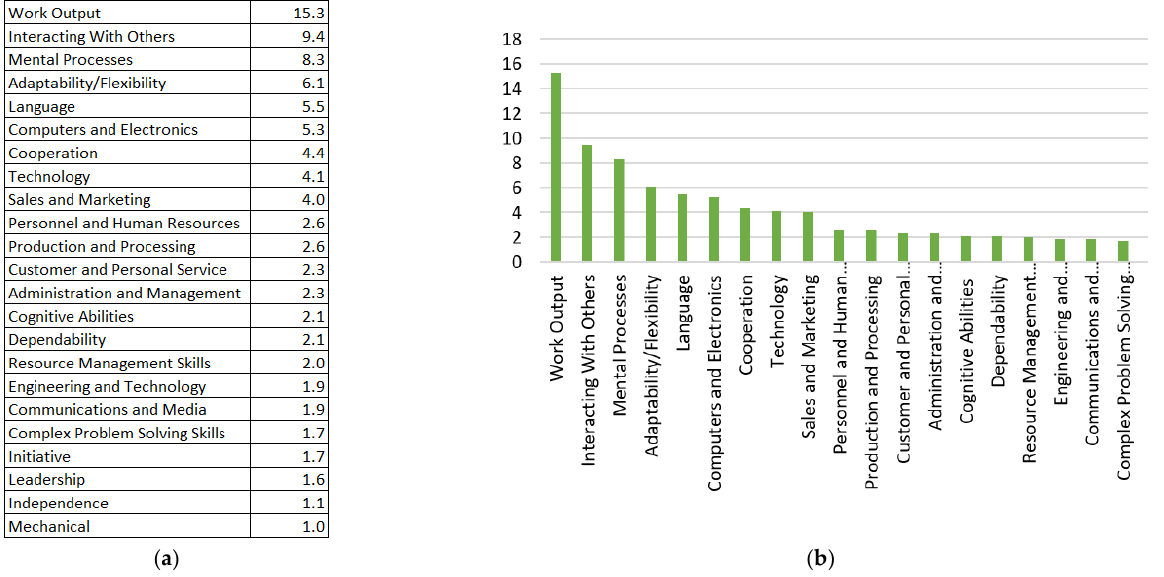
Figure 7. Percentage share of most important number of skills mentioned; ( a ) Skills more important in Europe, by number of mentions, Cedefop [56,58]; ( b ) Graphical view of ( a ). Source: own elaboration based on data from Cedefop Europe [56,58].